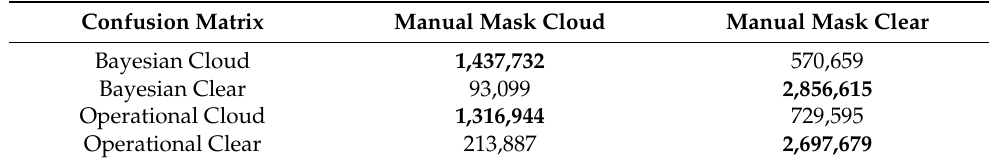
Table 5. Confusion matrices for Bayesian and operational cloud masks compared to manually masked AATSR data from the SYNERGY and ESA DUE GlobTemperature projects. The numbers in bold are the observations correctly classified by each